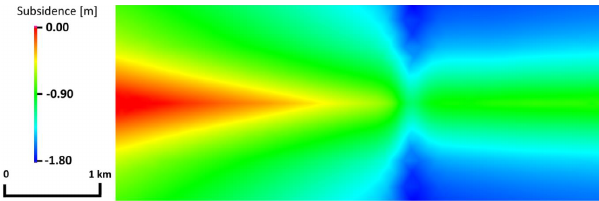
Figure 4. Test case 1: land subsidence after 10 years of water with- drawal.